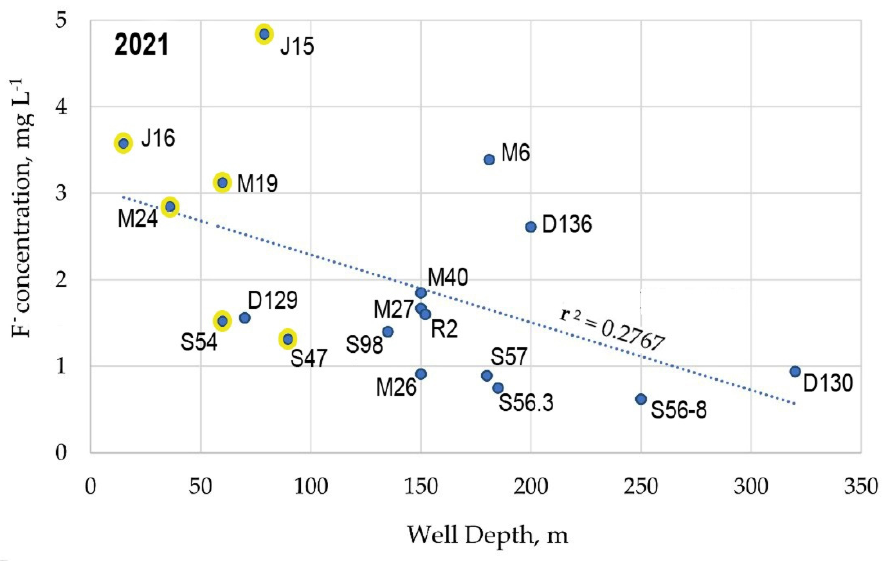
Figure 4. F − concentration vs. well depth for 2021 data. Points with a yellow rim are located at a discharge area.